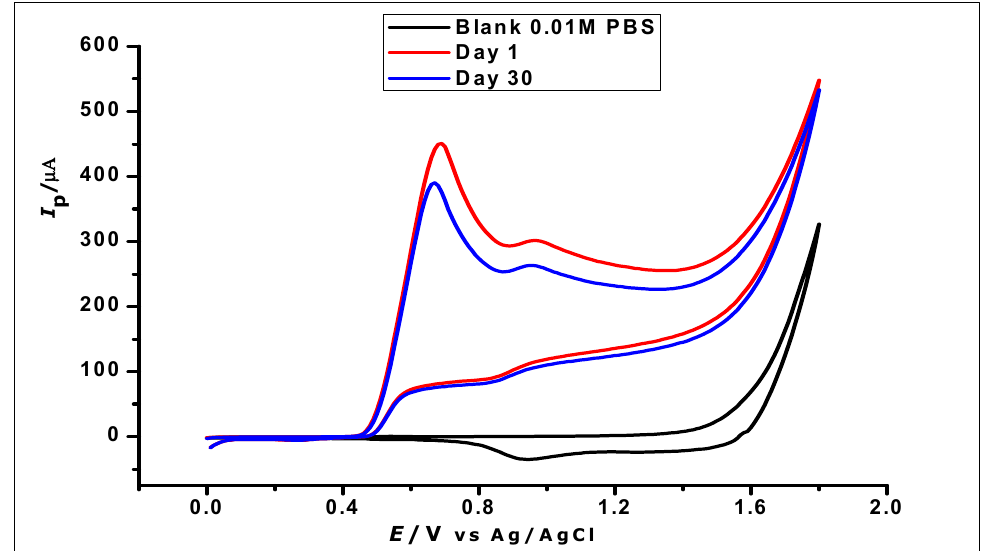
Figure 15. Cyclic voltammograms showing the determination of 1 × 10 − 2 mol L − 1 GA in 1 × 10 − 2 phosphate buffer at pH 2.0 and scan rate of 100 mVs − 1 on a day one and day thirty.